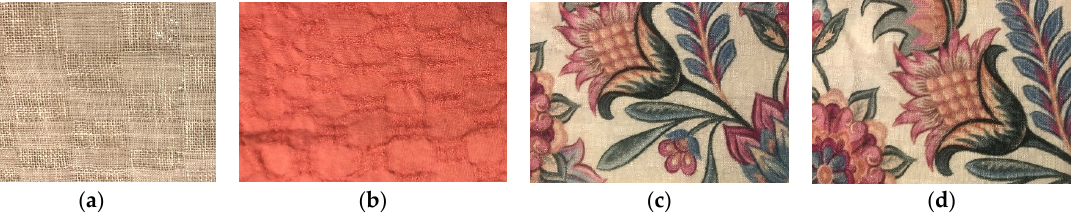
alterations of relief, which was conditioned by the type of weave. Due to shrinkage, the width of fabrics was also altered [17–19].